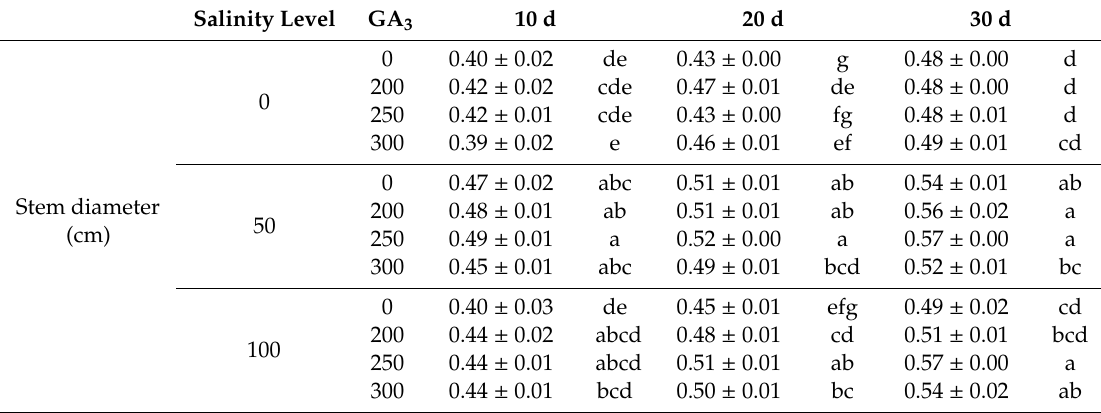
Table 2. E ff ects of di ff erent levels of exogenous GA 3 on stem diameter of caster bean seedlings grown under three levels of NaCl treatment: 0 (control), 50, and 100 mM.